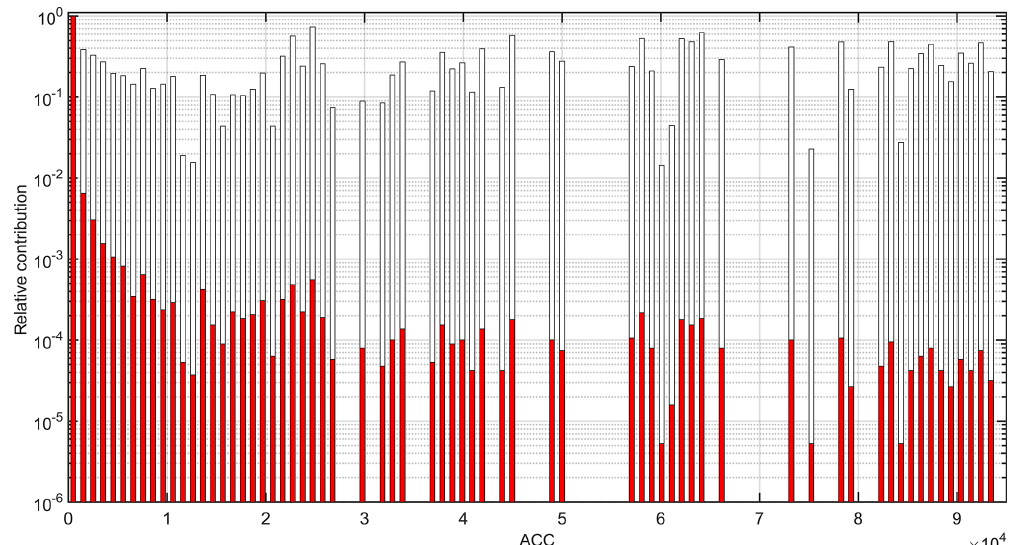
Figure 4. ACC bins ( x axis) vs. the relative contribution ( y axis). The grid points are binned by their ACC value. The red bars show the relative contribution (largest contribution normalized to one) by the number of grid points in this bin only. The white bars show the distribution using the number of grid points in this bin and weighing ACC · w .